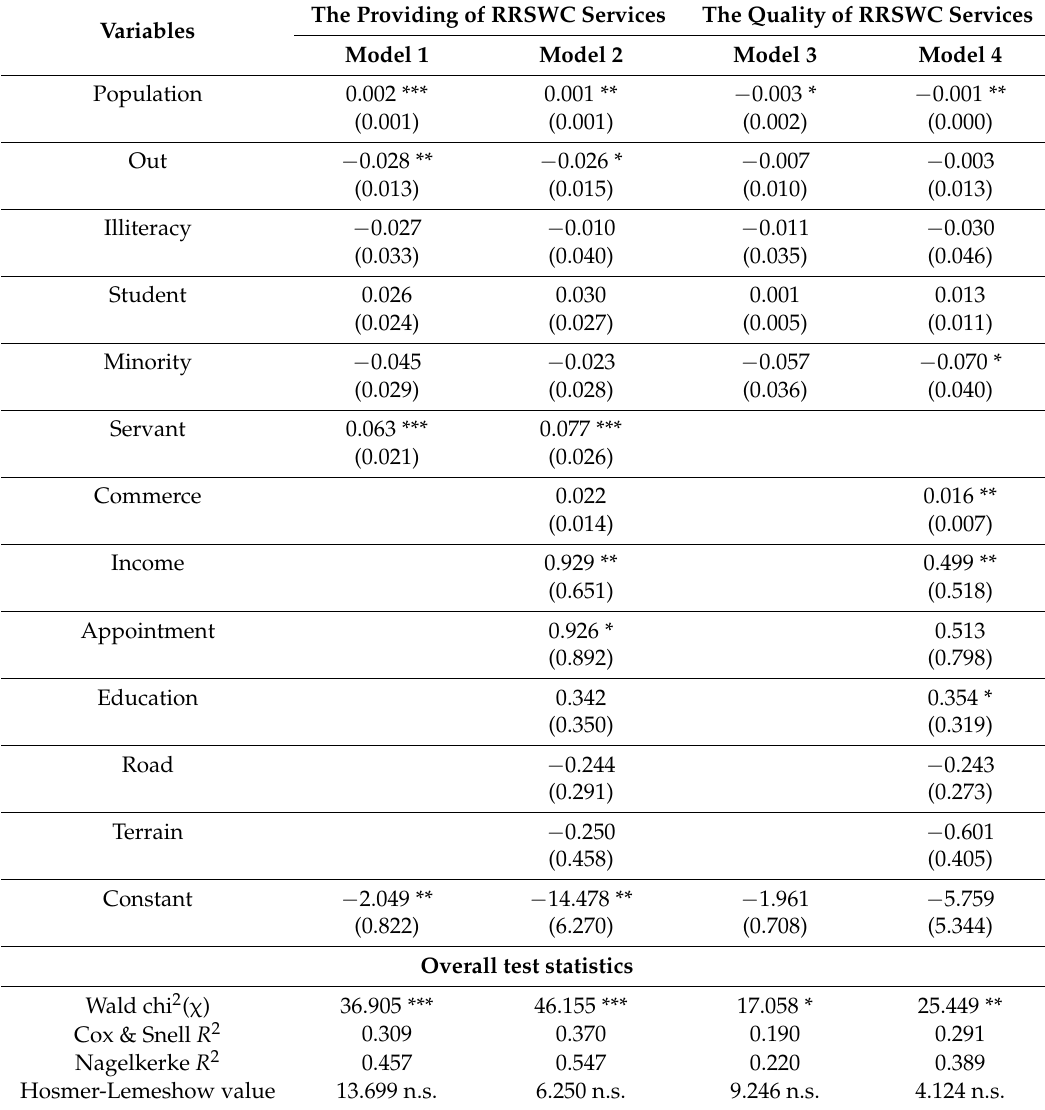
Table 3. Econometric model results of the village population structure and RRSWC services 1